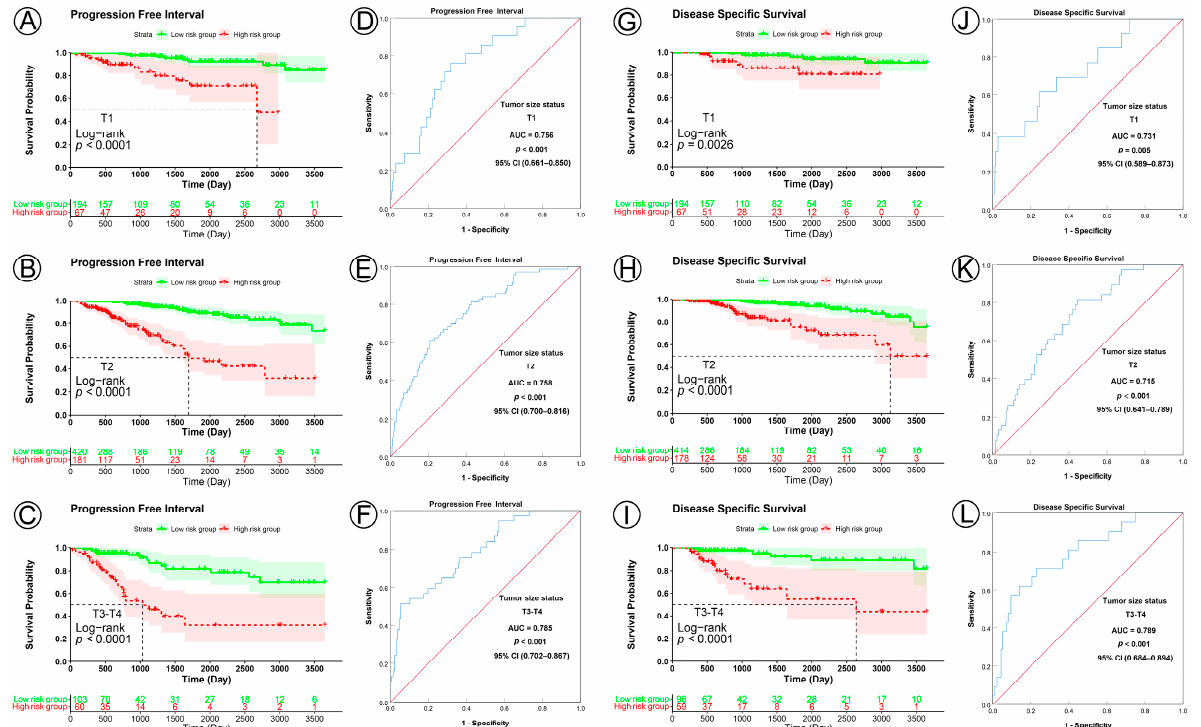
Figure 5. KM and ROC curve analyses of patients stratified by tumor size status. ( A – C , G – I ), KM curves of PFI and DSS for high- and low-risk groups in the T1, T2, and T3–T4 subgroups. ( D – F , J – L ), ROC analysis showed the sensitivity and specificity of prognostic signature for predicting PFI